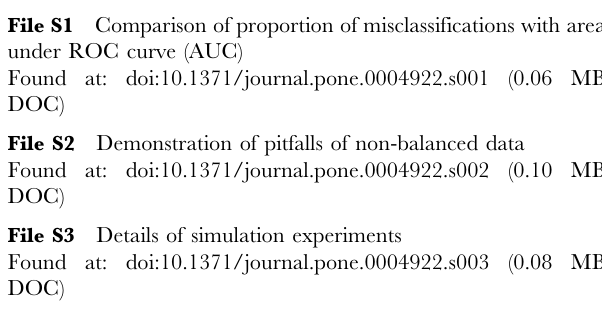
Table 1. Characteristics of gene expression microarray datasets analyzed in this study.